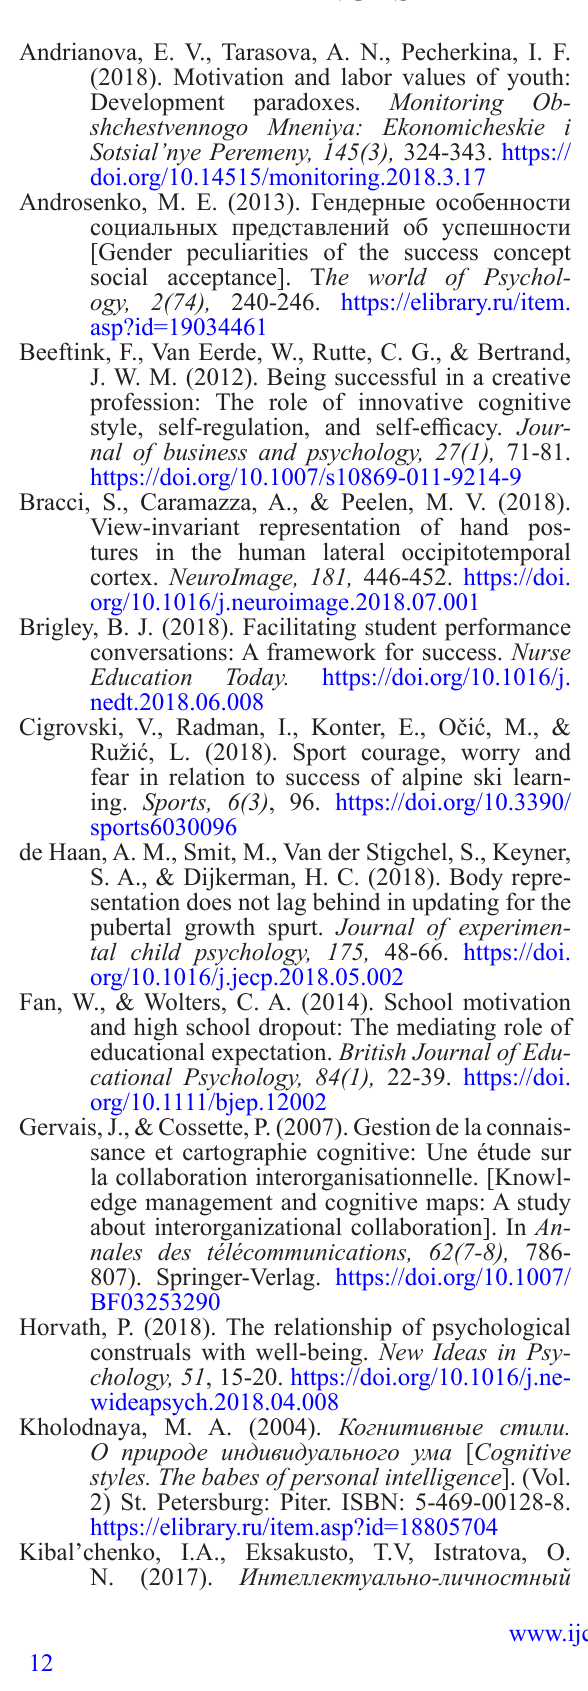
ресурс субъекта развития: теоретические основы [ Intellectual and personal resource of the subject of development: theoretical bases ]. Taganrog: Southern Federal University